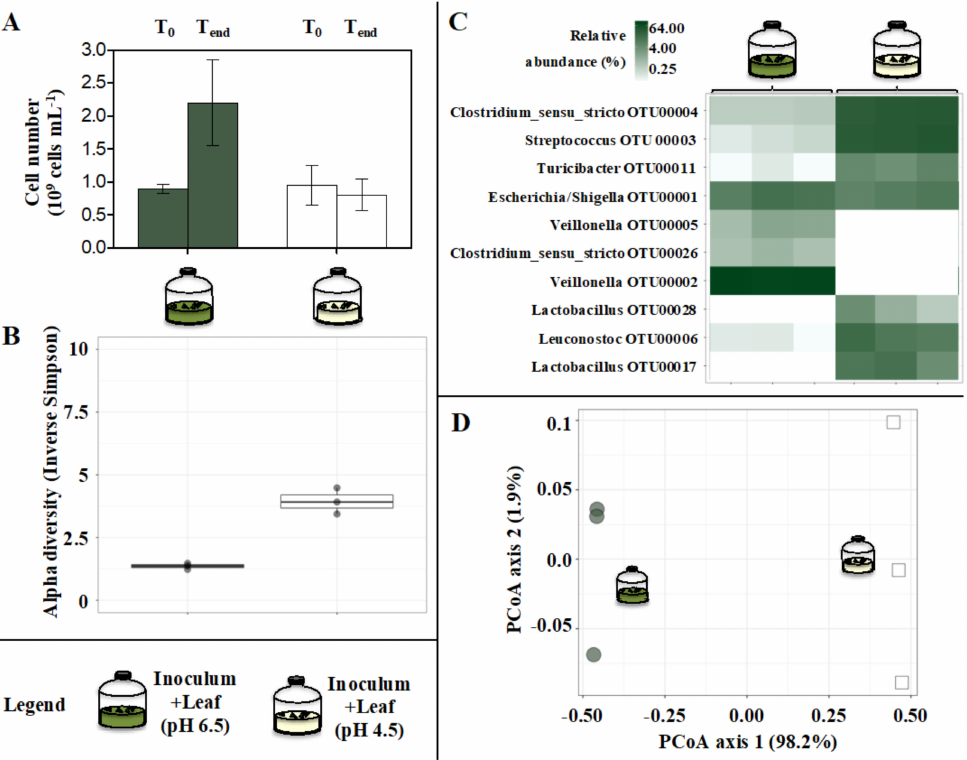
Figure 7. Microbial cell number ( A ), final alpha diversity ( B ), final predominant microbial taxa ( C ) and Principal Coordinate analysis (PCoA) ( D ) describing the final microbial community composition in In vitro tests inoculated with gut microbiomes from giant panda fecal samples and incubated with a different initial pH (either 6.5 or 4.5). Keys reported in the